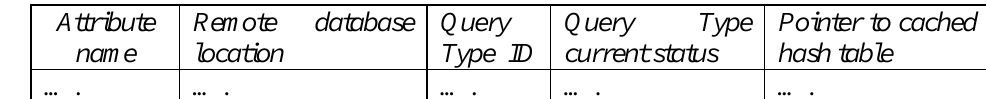
Fig. 6: System architecture Table 2: Fragment of a